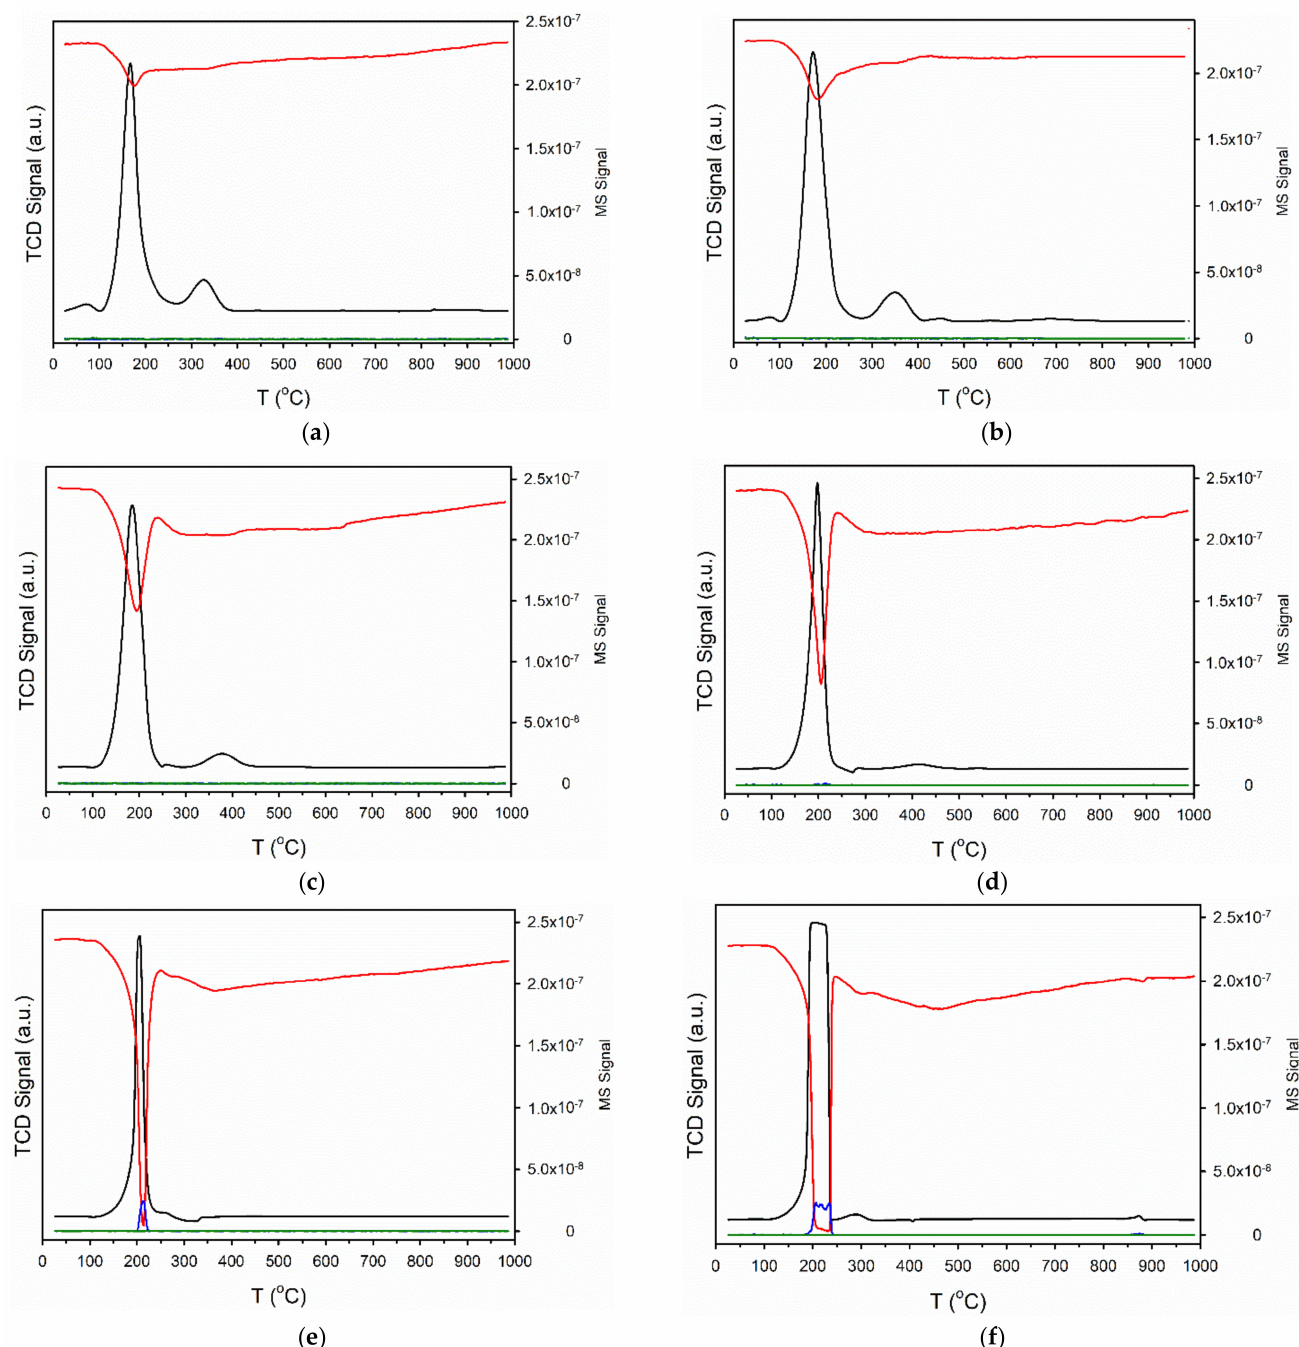
Figure 4. TCD signal (black) and MS signals of (red) H 2 , (blue) CO, and (green) CO 2 during temperature programmed reduction in 10%H 2 /Ar for ( a ) 2%Pt/ZrO 2 , and the same doped with ( b ) 0.55%Rb, ( c ) 1.86%Rb ( d ) 2.79%Rb, ( e ) 4.65%Rb, and ( f )